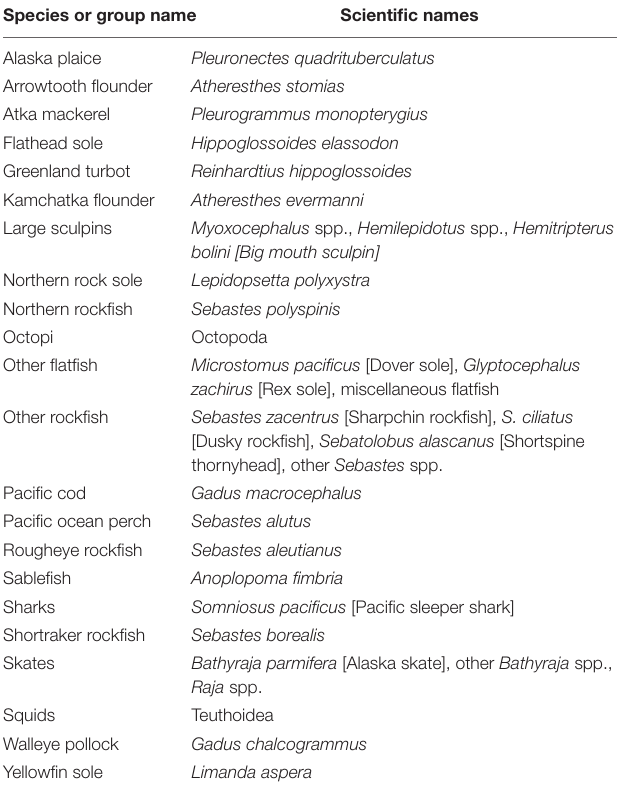
TABLE 1 | Groundfish species or species complexes managed under the Bering Sea/Aleutian Islands ecosystem harvest cap.